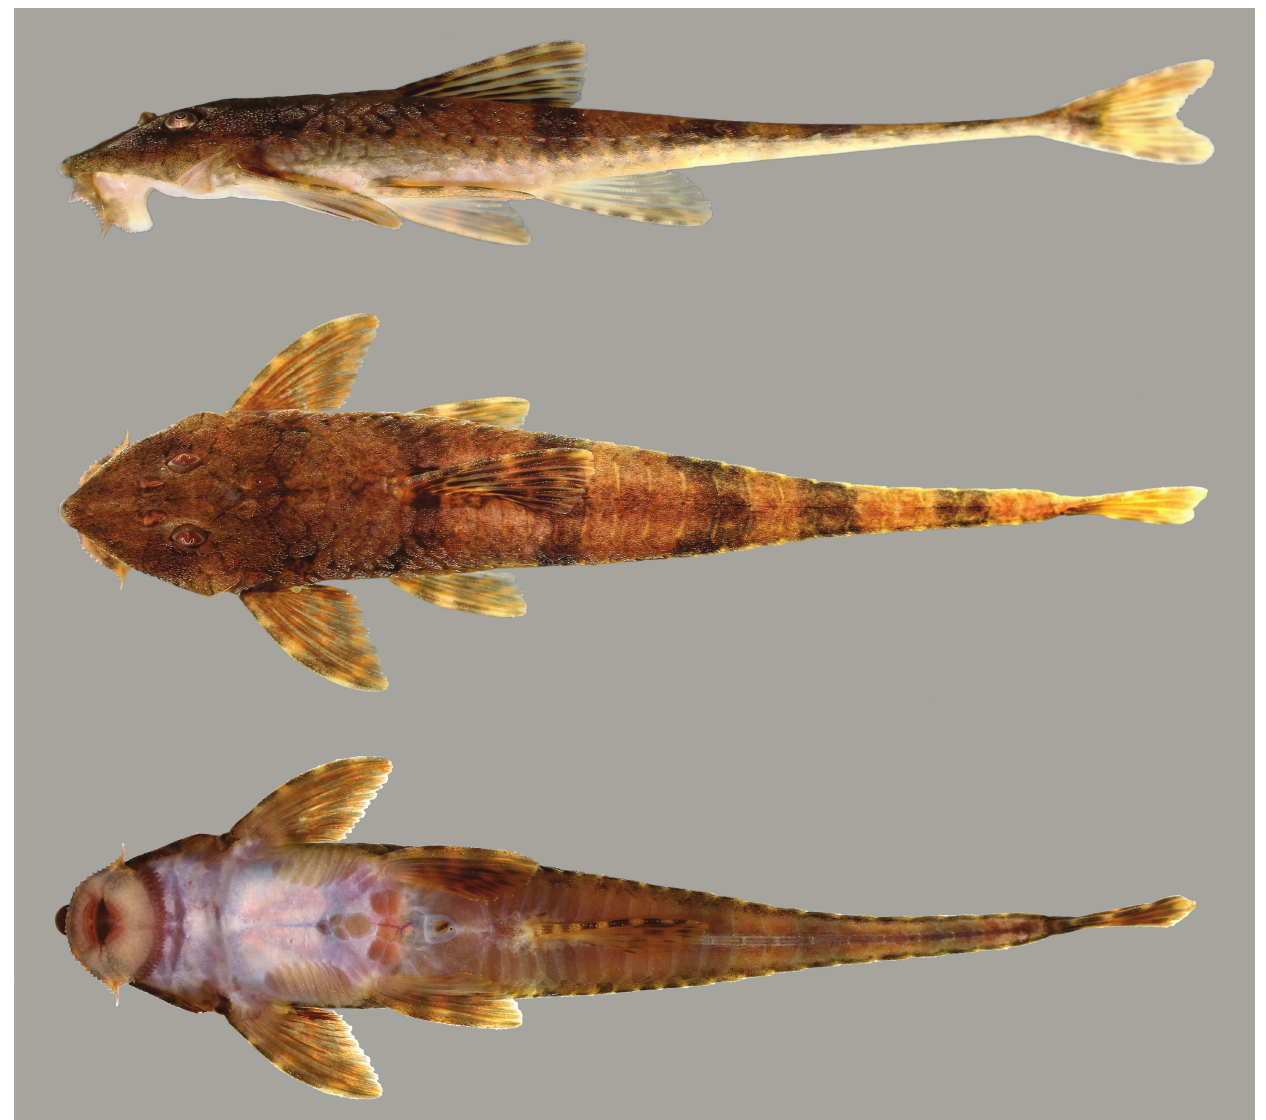
Fig. 1. Lateral, dorsal and ventral views of a Rineloricaria aequalicuspis individual (110 mm TL). Ventral view shows the arrangement of the abdominal plates. Photograph courtesy of L. R.